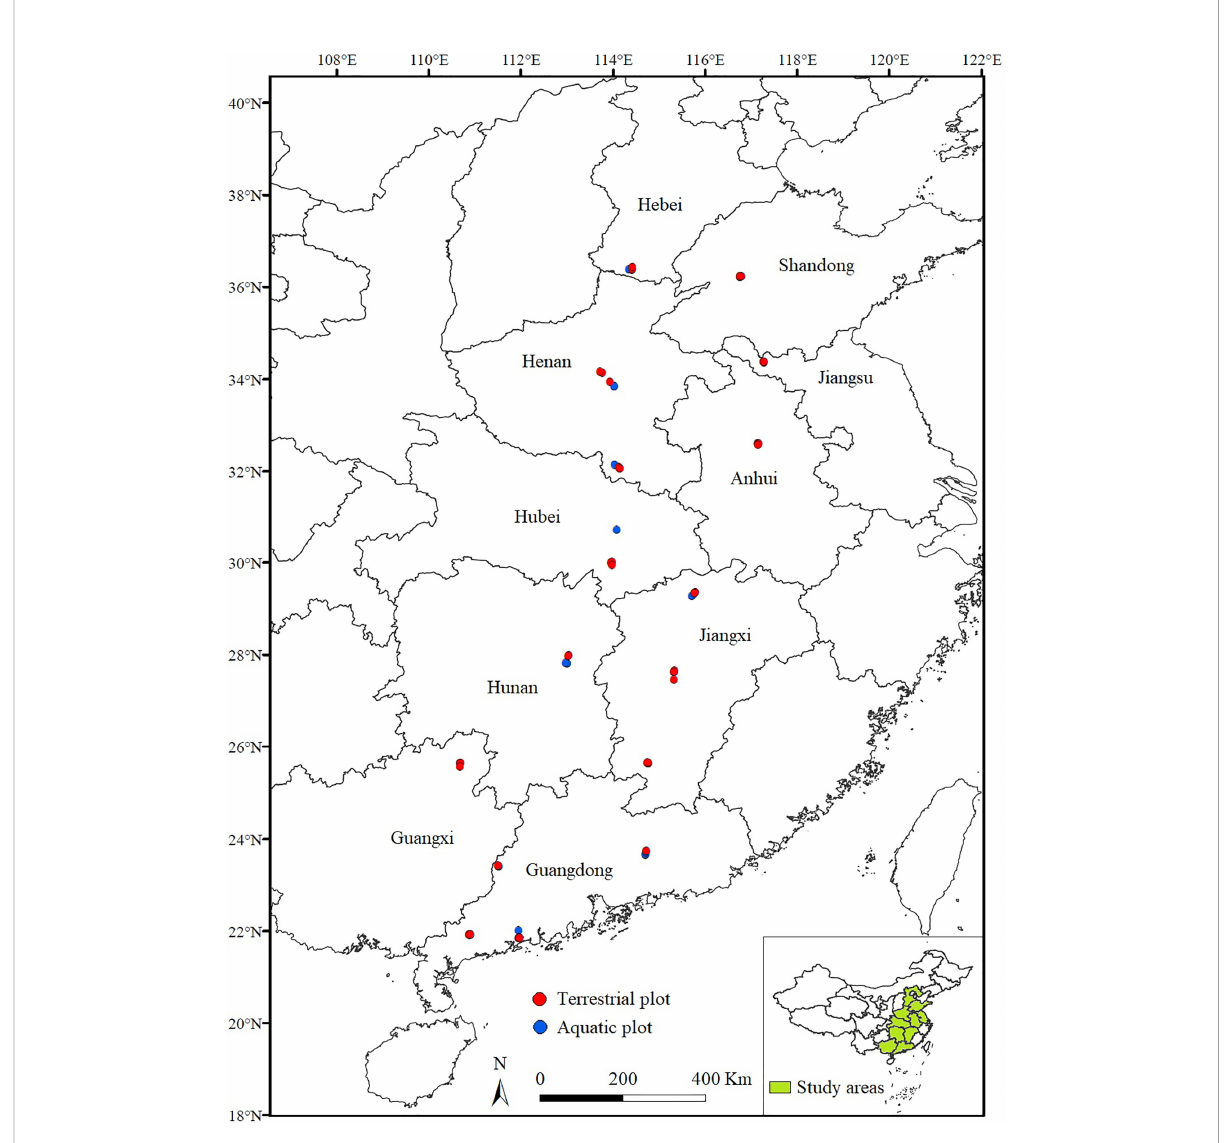
FIGURE 1 Sampling plot distributions of A . philoxeroides communities across amphibious habitats along a latitudinal gradient in